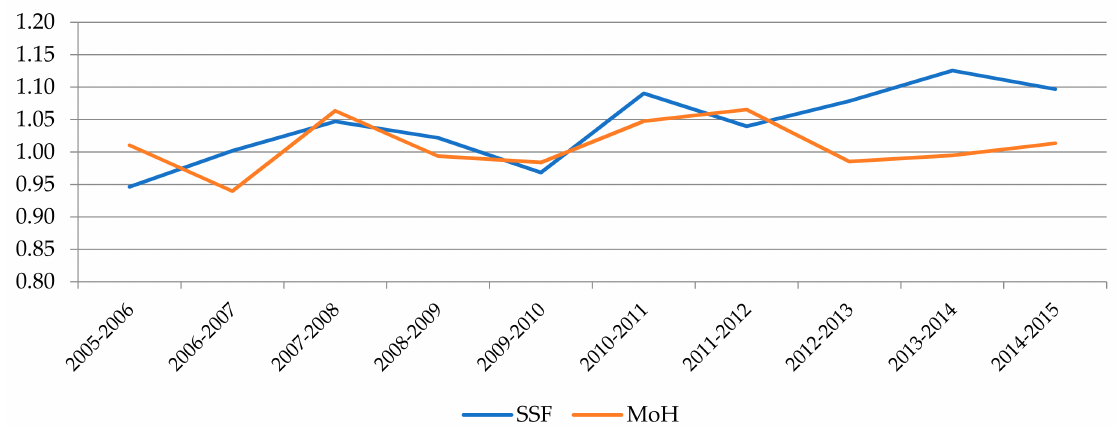
Figure 2. Evolution of MPI by type of management.